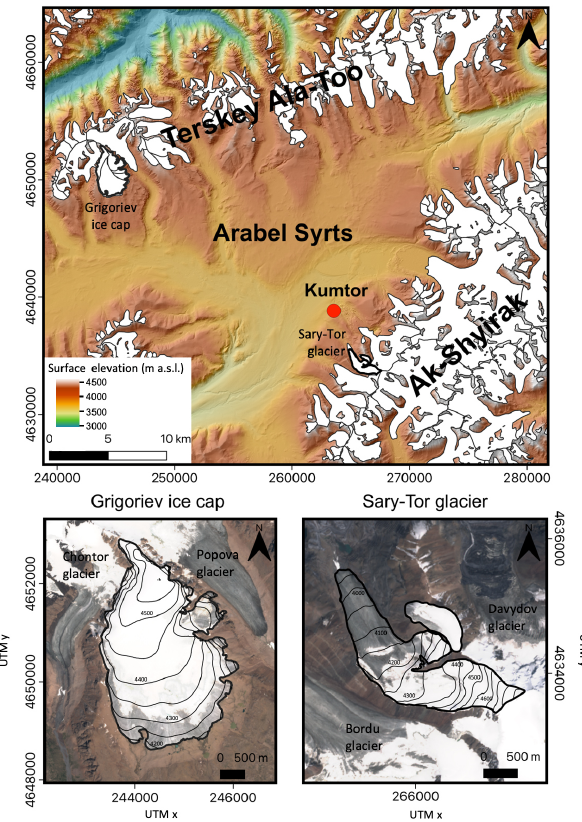
Figure 1. The Grigoriev ice cap and the Sary-Tor glacier located in their respective mountain range in the inner Tien Shan. All the glaciers of the Randolph Glacier Inventory version 6 (from 2002) are indicated in white colour on the upper map. The black out- line of the glaciers in the lower maps represents the extent of the ice mass in August 2021. Glacier elevation contours are added for every 50m. The location of the Kumtor–Tien Shan meteorologi- cal station is added with a red dot. The background topography is from TanDEM-X, and the satellite images are from Sentinel-2 on 26 July